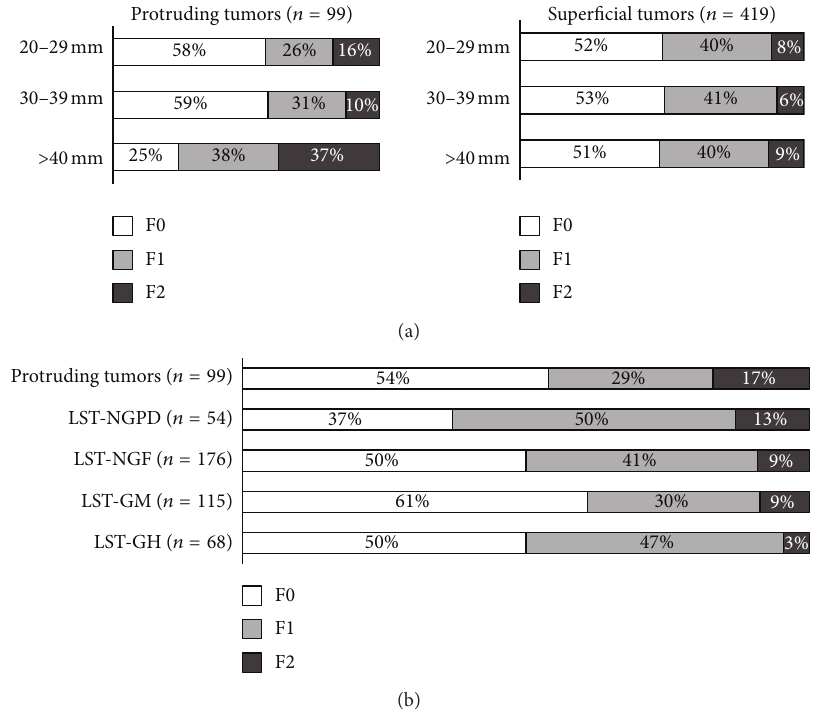
Figure 2: Clinical features of tumors with mild and severe fibroses. (a) There was a significantly higher incidence of severe fibrosis in protruding tumors > 40mm in diameter. However, there was no significant difference in the incidence of fibrosis in superficial tumors. (b) The incidence of severe fibrosis (F2) was higher in protruding tumors and LST-NGPD. F0: no fibrosis, F1: mild fibrosis, F2: severe: fibrosis, LST: laterally spreading tumor, NGPD: nongranular pseudodepressive type, NGF: nongranular flat type, and GM: granular nodular-mixed type, GH: granular homogenous